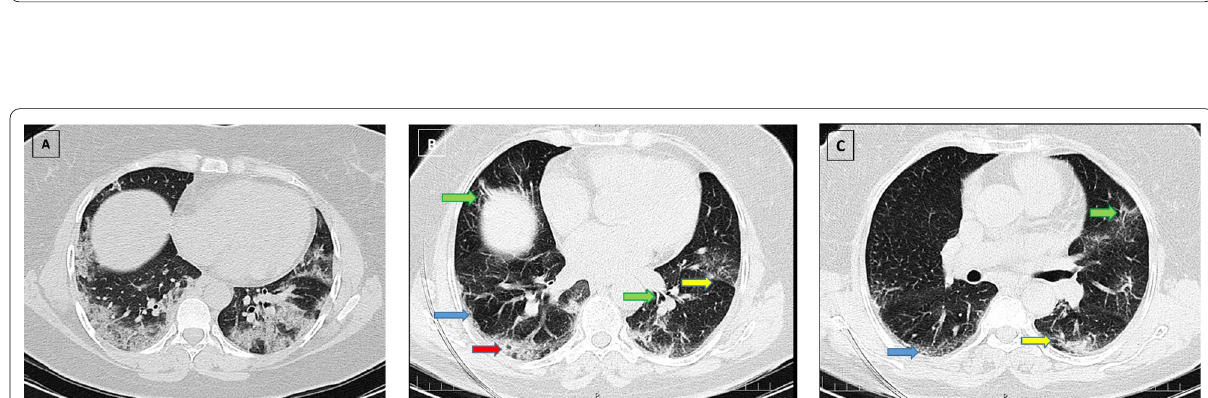
Fig. 3 A 46-year-old female patient presented with fever and dyspnea, who was admitted to hospital and was discharged on day 15 of admission. Ground glass opacities and consolidations in several pulmonary lobes are observed in the initial CT scan ( A ). The total CT severity score was calculated as 14, and the disease severity was moderate. Three-month follow-up chest CT ( B ) shows some parenchymal bands and vacuolation (red arrow) and interlobular septal thickening (blue arrow) in several lobes. Six-month follow-up chest CT ( C ) shows a few parenchymal bands (red arrow) and interlobular septal thickening (blue arrow), which was diminished in comparison to the previous CT